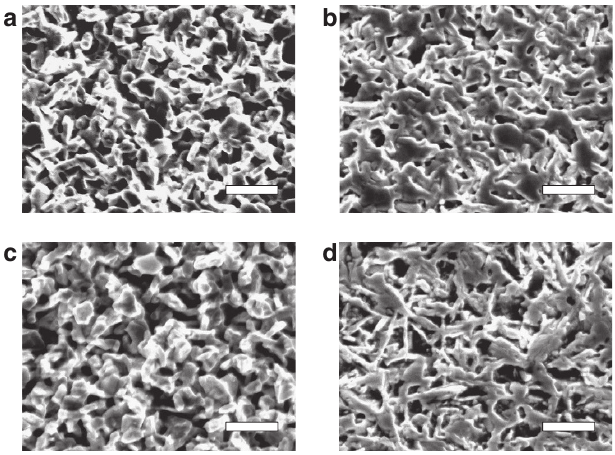
Figure 5 | Microscopic images by scanning electron microscopy. ( a ) Reduced Ca 2 RuO 3.74 (#1), ( b ) oxidized Ca 2 RuO 4.03 (#2), ( c ) re-reduced Ca 2 RuO 3.69 (#3) and ( d ) reduced Ca 2 Ru 0.92 Fe 0.08 O 3.82 . The morphology is apparently reversible in successive heat treatment: #1 - #2 - #3. Scale bars, 20 m